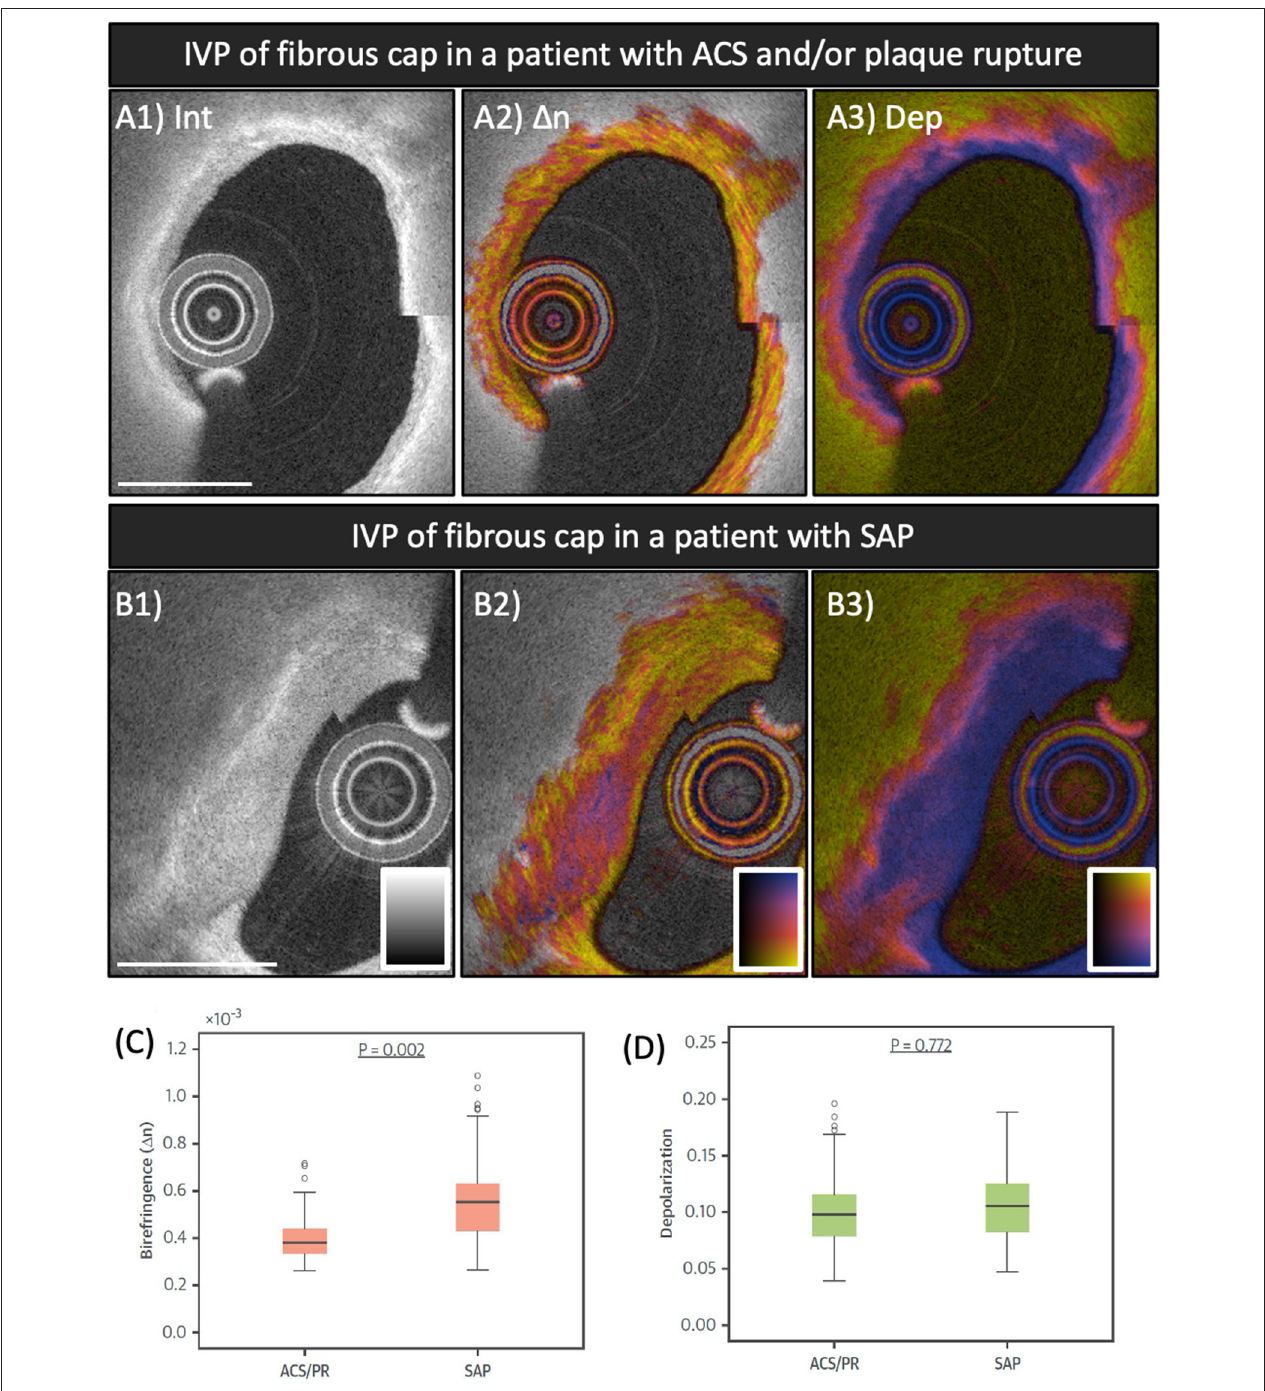
FIGURE 4 | Polarization features of fibrous caps of culprit lesions in ACS and SAP patients. (A1–A3) IVP of the culprit lesion in a patient with ACS. (B1–B3) IVP of the target lesion in a patient with SAP. (C,D) Comparison of mean birefringence and depolarization measured in the segmented fibrous caps between patients with ACS/PR and SAP. Fibrous caps in ACS/PR patients featured significantly lower birefringence compared to those in SAP patients. ACS, acute coronary syndrome; IVP, intravascular polarimetry; PR, plaque rupture; SAP, stable angina pectoris. Reproduced from Otsuka et al. (35, 36).